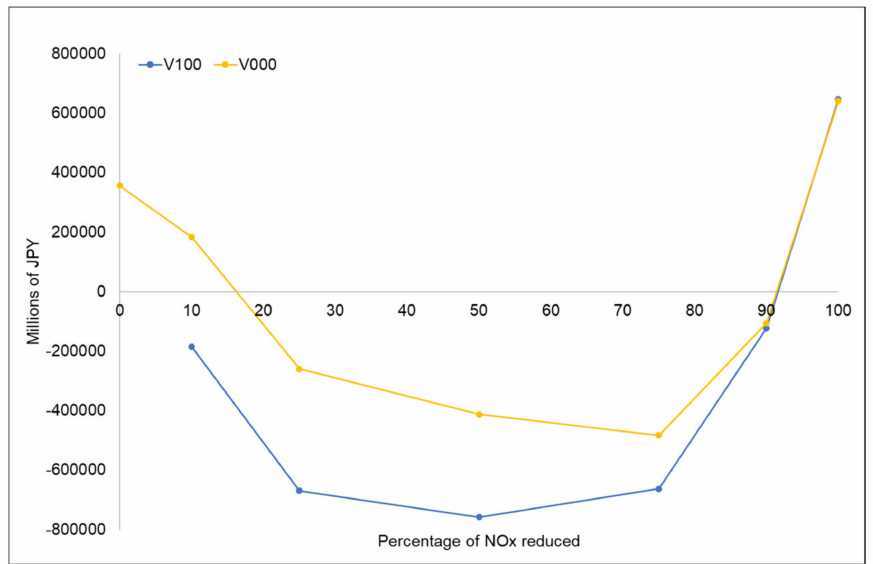
Figure 7. Health benefits measured as the economic change for the range of NOx reductions applied in the different evaluated scenarios.